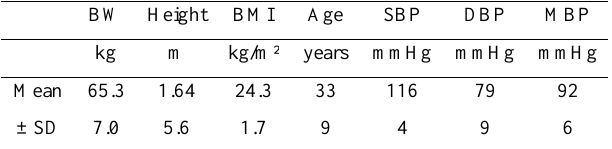
Table 1. Characteristics of the participants. BW - body weight; BMI - body mass index; SBP - systolic blood pressure; DBP - diastolic blood pressure; MAP - mean arterial pressure.